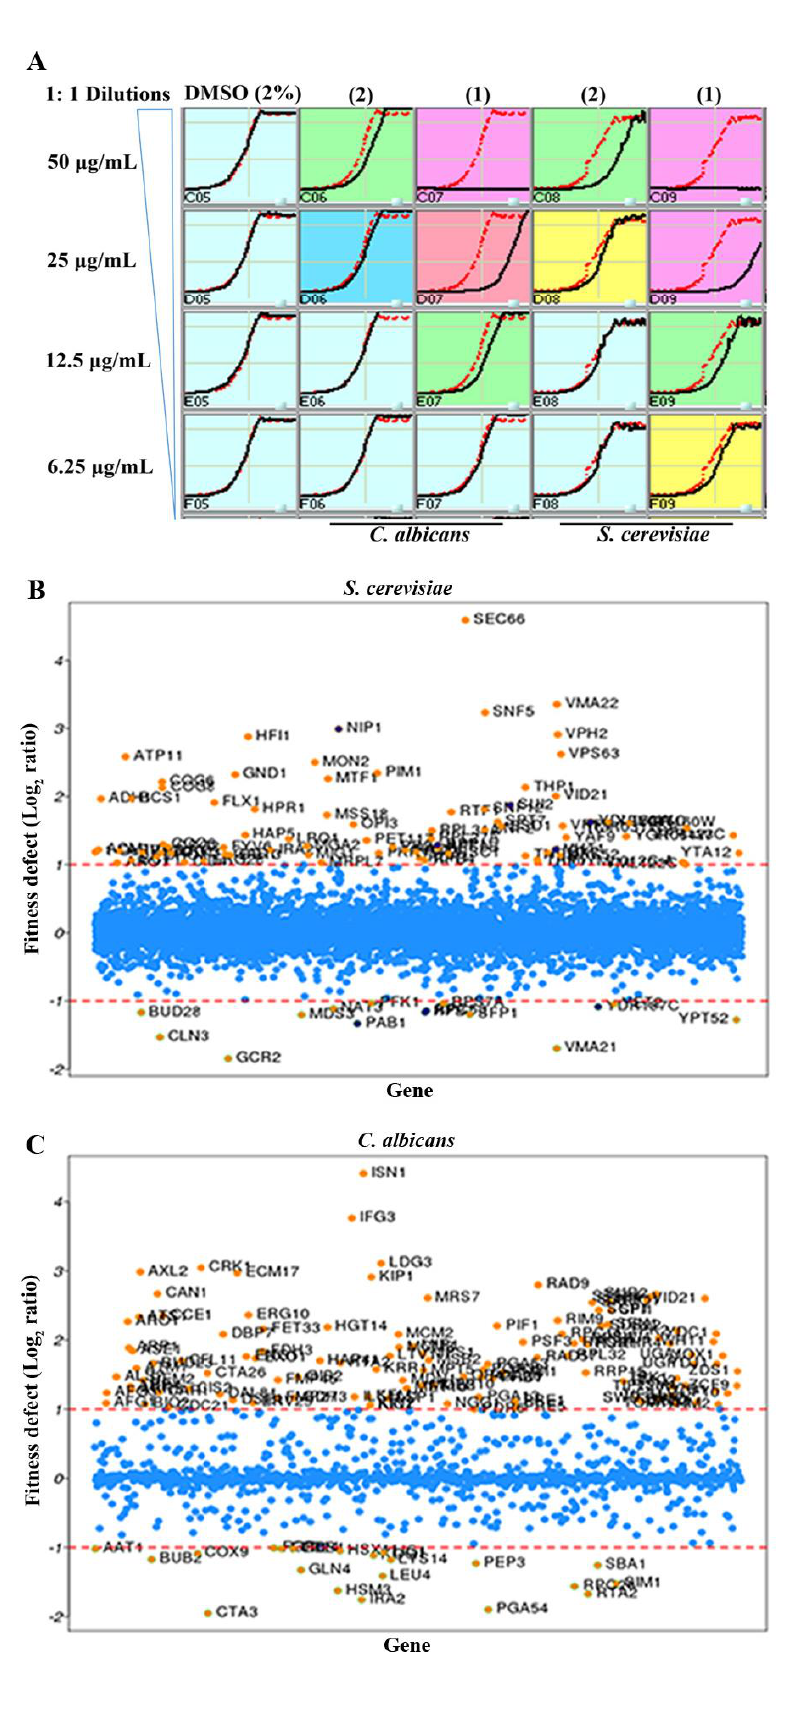
FIGURE 4: Genome-wide fitness assay. (A) Determination of IC-50 for drimenol (1) activity against C. albicans and S. cerevisiae . Yeast growth conditions (YPD medium at 30 o C) were used to determine the IC-50 values. The red line in each panel indicates growth of the DMSO reference. An IC-50 of ~25 μ g/ml for C. albicans and ~15 μ g/ml